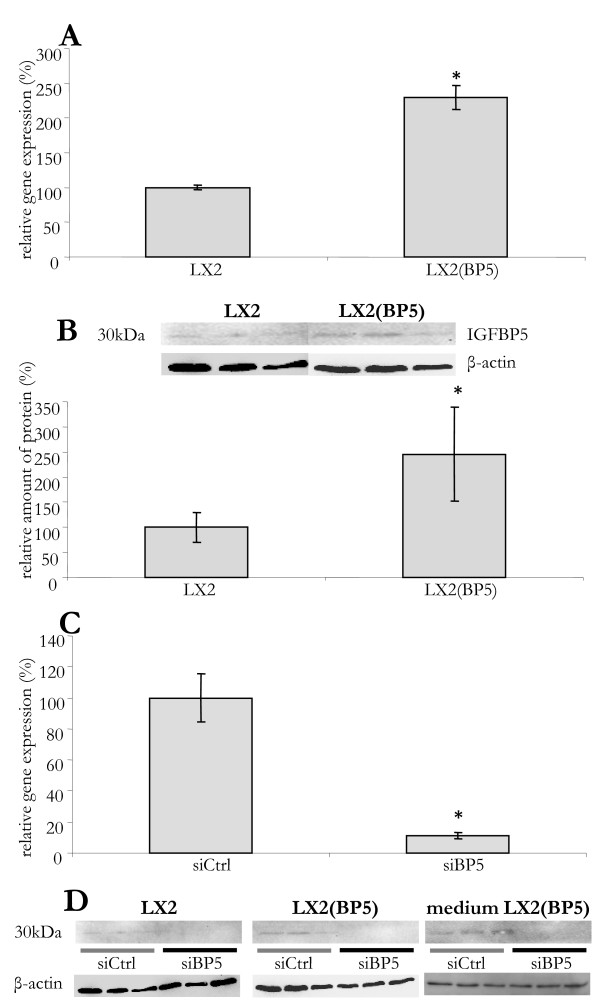
Modulation of IGFBP5 expression in LX2 cells. (A) IGFBP5 mRNA levels in control cells (LX2) and in cells with lentiviral overexpression of IGFBP5 (LX2(BP5)). RNA levels normalized to 36B4 are shown as a percentage of control cells. (B) IGFBP5 protein levels in control (LX2) and transduced (LX2(BP5)) cells as demonstrated on a Western blot (upper panel) and quantified using the LumiImager (lower panel). (C) Silencing of IGFBP5 expression. Cells were transfected with small interfering (si) RNA for IGFBP5 (siBP5) or with a control siRNA (siCtrl). RNA was isolated 48 h later and IGFBP5 mRNA levels were quantified, normalized to 36B4 and given as a percentage of control cells. (D) Proteins were isolated from the cells and the medium 48 h after small interfering RNA (sRNA) transfection. The presence of IGFBP5 protein was visualized by Western blotting in LX2 and LX2(BP5) cells transfected with control siRNA (siCtrl) and IGFBP5 siRNA (siBP5) and in medium obtained from transfected LX2(BP5). The results are given as a percentage of the control cells. The error bars represent standard deviations, with asterisks denoting significant difference (P < 0.05).